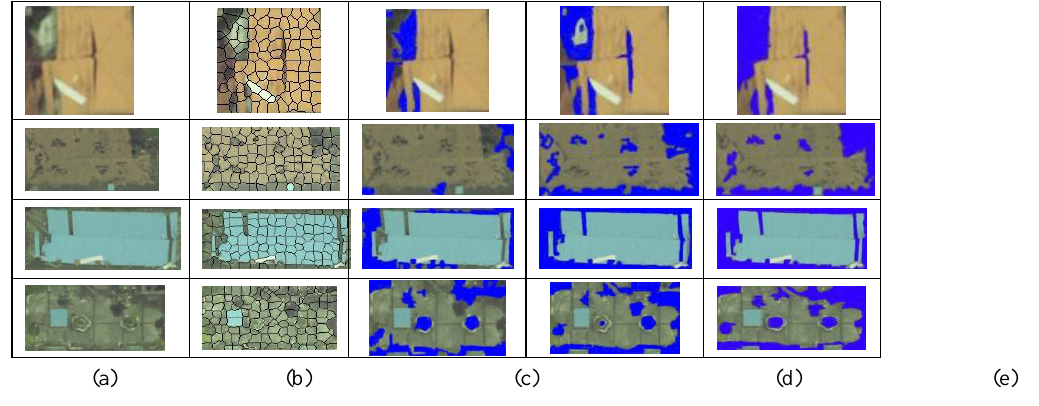
Fig.6 Some examples of result images by different methods in Table I: (a) Original rooftops (b) Superepixels (c) result images by Surf+VBOW+SVM (d) result images by Gabor+VBOW+SVM (e) result images by the proposed